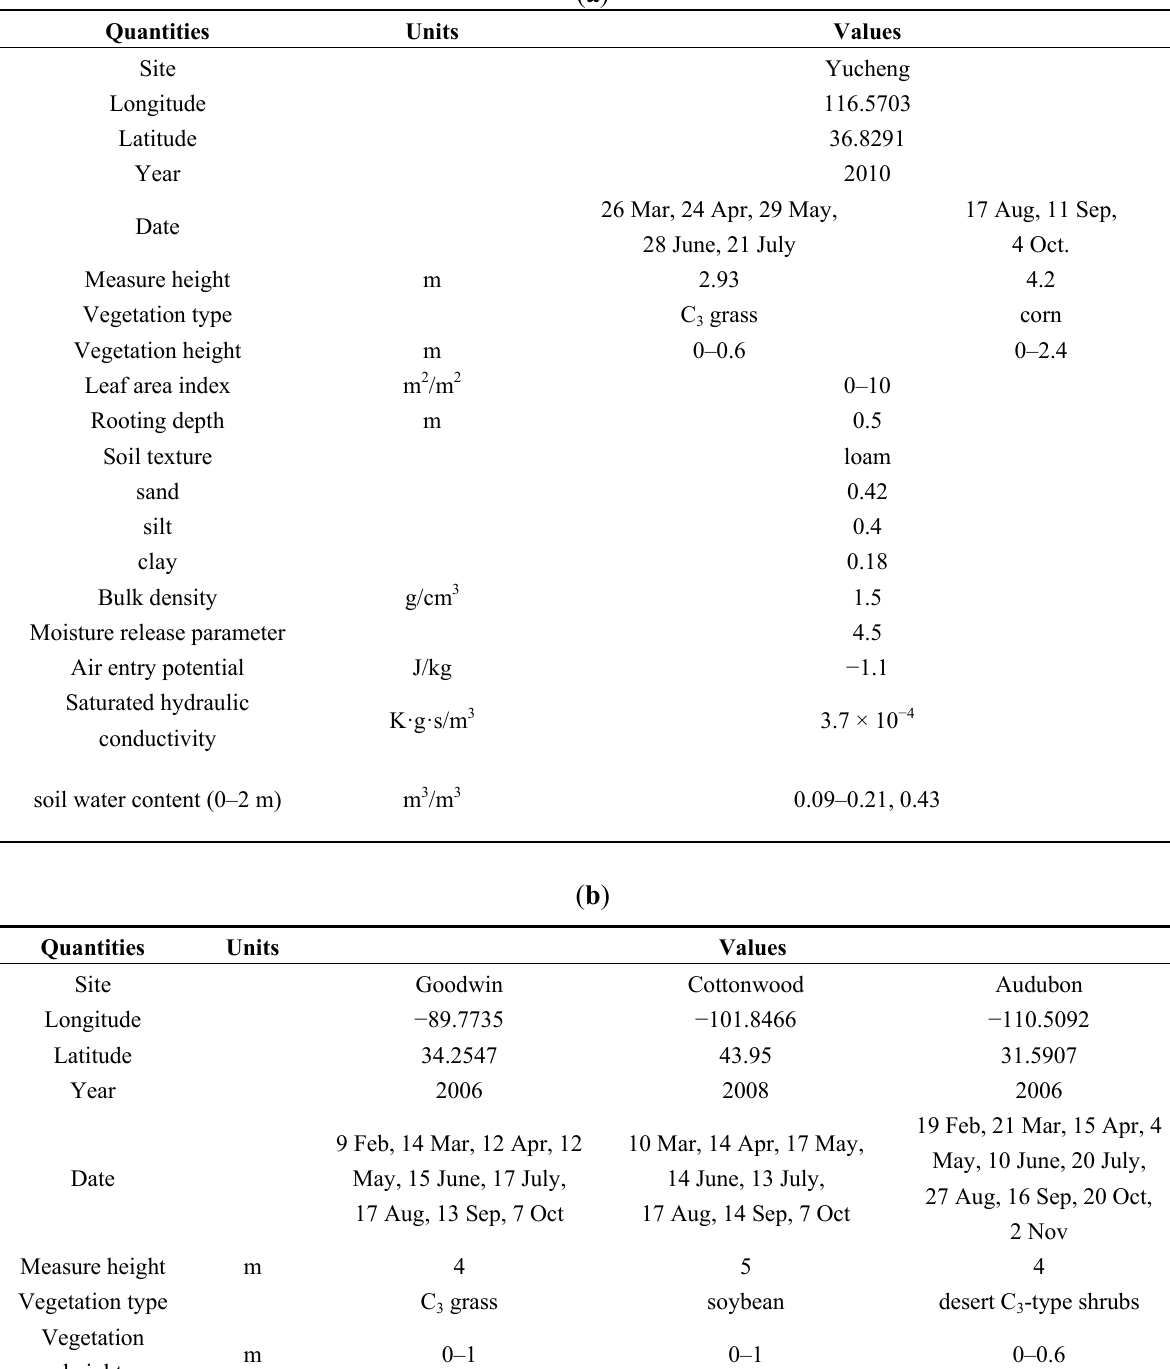
Table A1. The main input quantities required by the ALEX model and the values used in model simulation for forcing data ( a ) from the Yucheng site and ( b ) from three Ameriflux